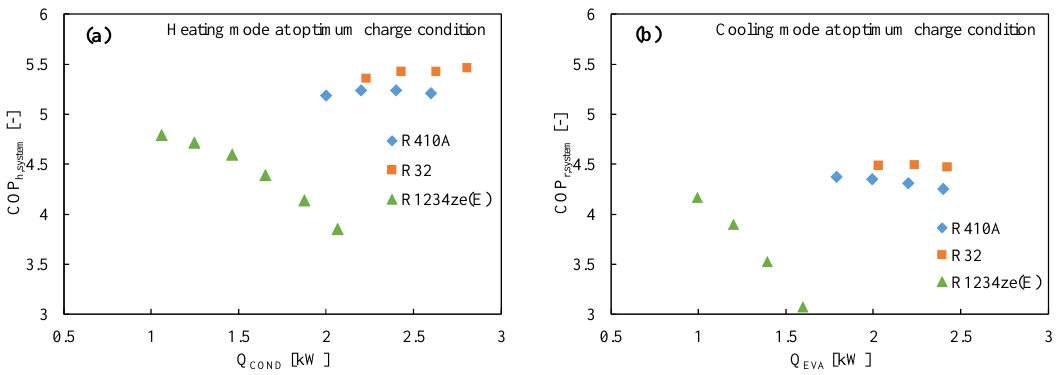
A double tube-type counter flow heat exchanger was used in the experiment. In the heating mode, the heat sink water temperatures at the inlet and the outlet of the con- denser were set at 20 °C and 45 °C, respectively, and the corresponding inlet and outlet water temperatures in the evaporator were kept constant at 15 °C and 9 °C, respectively. In the cooling mode, the heat sink water temperature at the inlet and the outlet of the condenser was maintained at 30 °C and 45 °C, respectively, and the inlet and outlet wa- ter temperatures in the evaporator were maintained at 20 °C and 10 °C, respectively. The heat transfer rate varied from 1.4 kW to 2.6 kW by adjusting the refrigerant flow, compressor rotational speed, and water flow. The degree of superheat was kept constant at 3 – 4 °C over the entire range of test conditions.